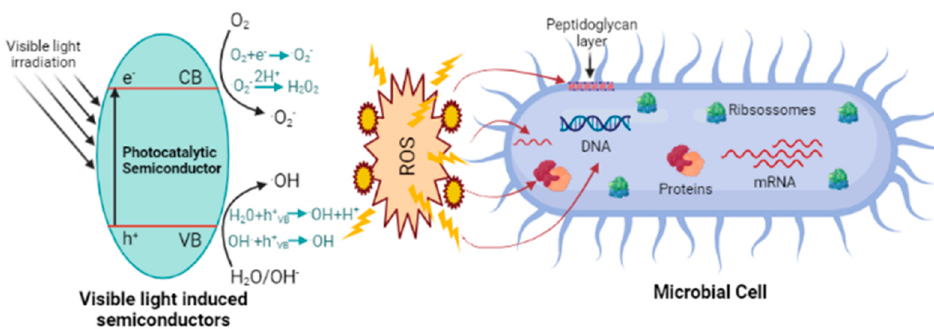
Figure 3. The possible mechanisms of antimicrobial activities exhibited by photocatalytic semiconductors in the right side of the figure and in the left side, the activation of the photocatalytic semiconductor by visible light. Created with BioRender.com.